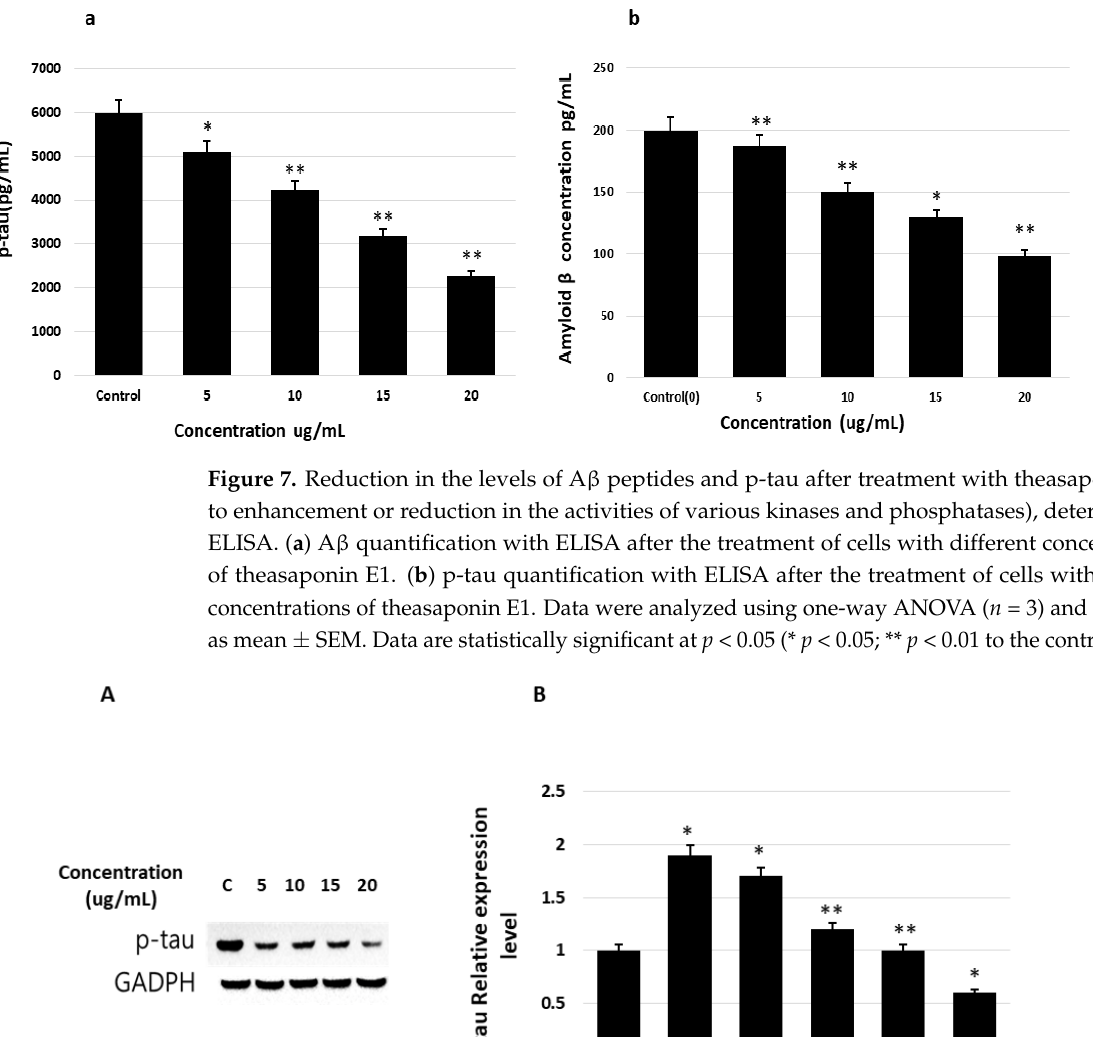
Figure 8. Effects of theasaponin E1 on tau phosphorylation levels determined by WB. Protein expression as fold change relative to that of the control (actin) after normalization. ( A ) Western blotting results after treatment of cells and expression of tau, p-tau, and GAPDH on PAGE. ( B ) Phosphorylated-tau relative protein expression levels determined by western blotting. Data are shown as mean ( n = 3) ± SEM (* p < 0.01 and ** p < 0.001 compared to the control).